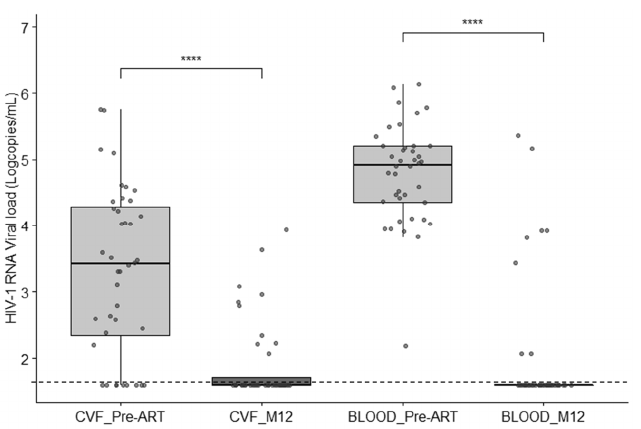
Figure 2. Scatter/box plot showing the viral loads in CVF and blood before and after 12 months of ART; **** p < 0.0001. Dashed line: threshold of viral load detection.